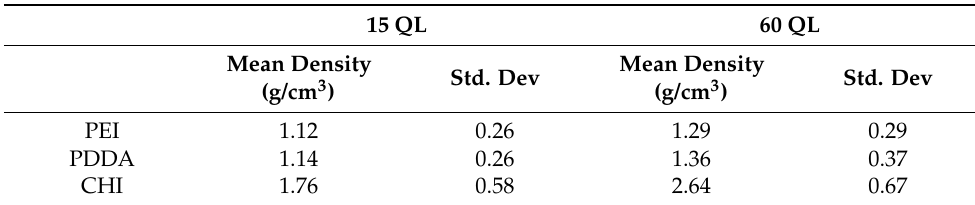
Table 4. Mean coating densities of PEI, PDDA and CHI coatings on glass microscopic slides at 15 QL and 60 QL.